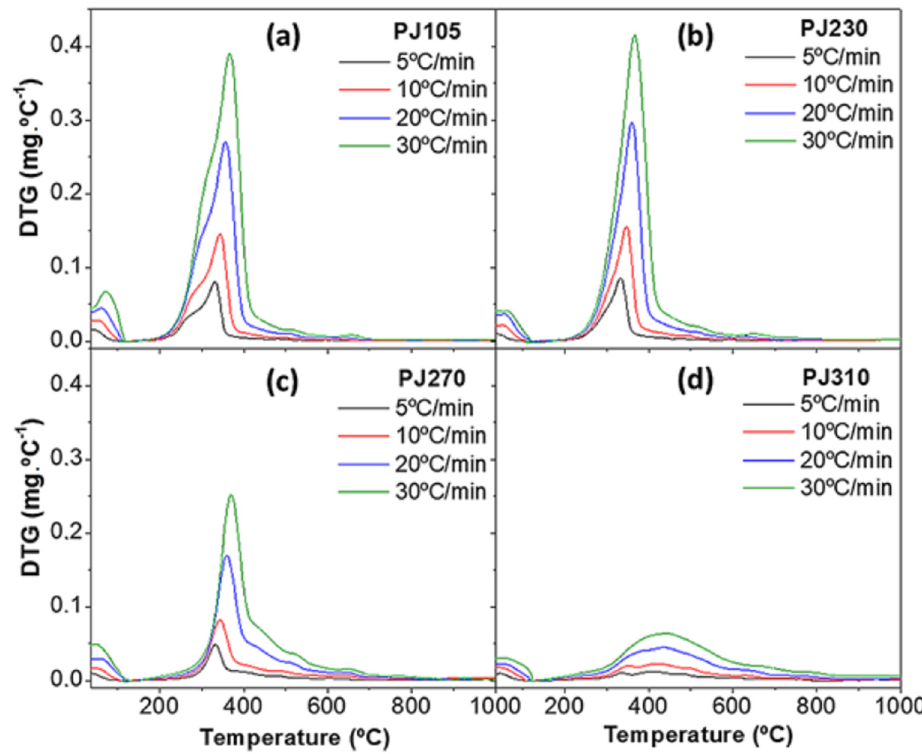
Figure 7. DTG profiles of P. juliflora samples at different heating rates of 5, 10, 20, and 30 °C/min for ( a ) raw biomass—PJ105; ( b ) PJ230; ( c ) PJ270; ( d ) PJ310.